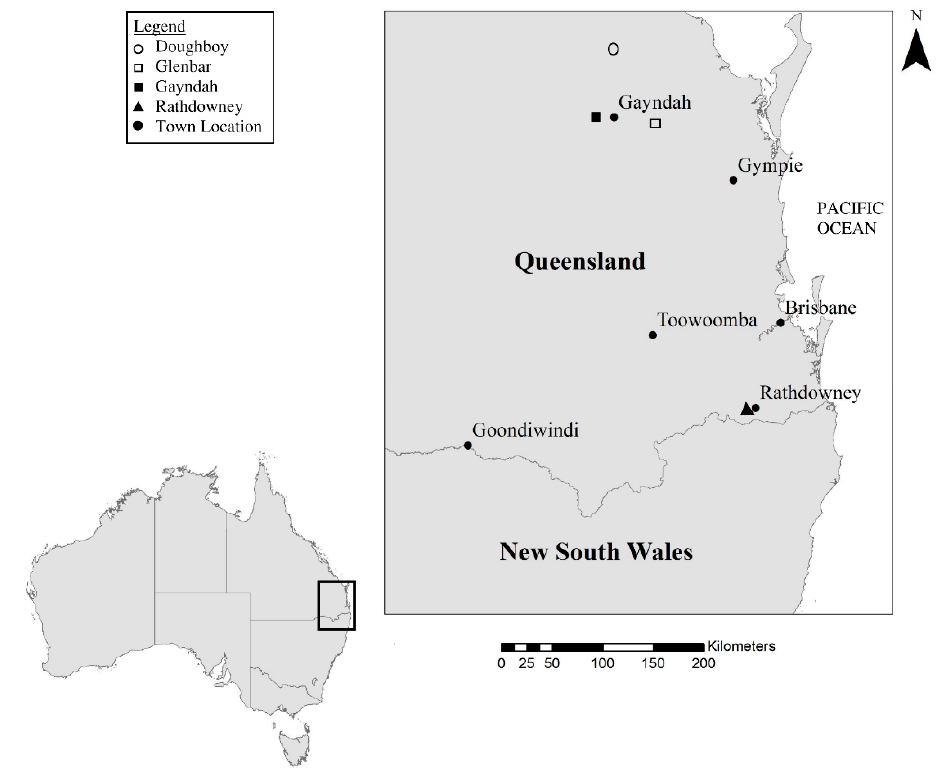
Figure 1. Case study property locations in southern Queensland, Australia. Base shape files sourced from the Australia Bureau of Statistics (https://www.abs.gov.au/statistics/standards/aus- tralian-statistical-geography-standard-asgs-edition-3/jul2021-jun2026/access-and-downloads/digi- tal-boundary-files, accessed on 28 December 2021) and Queensland Spatial Catalog (https://qld- spatial.information.qld.gov.au/catalogue/custom/index.page, accessed on 28 December 2021).